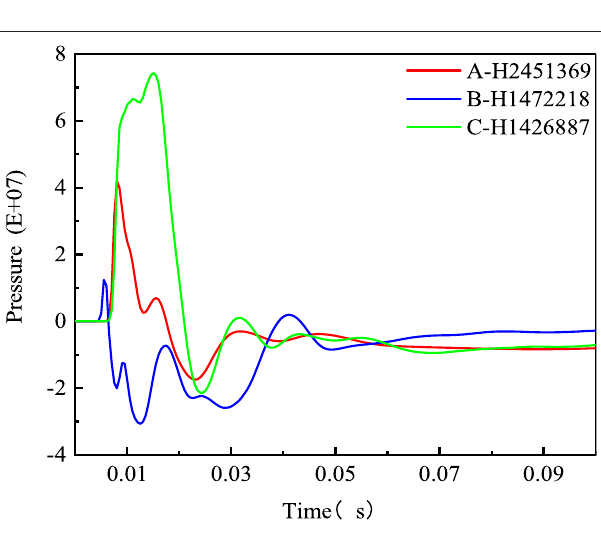
FIGURE 6 | Stress diagram of the monitoring